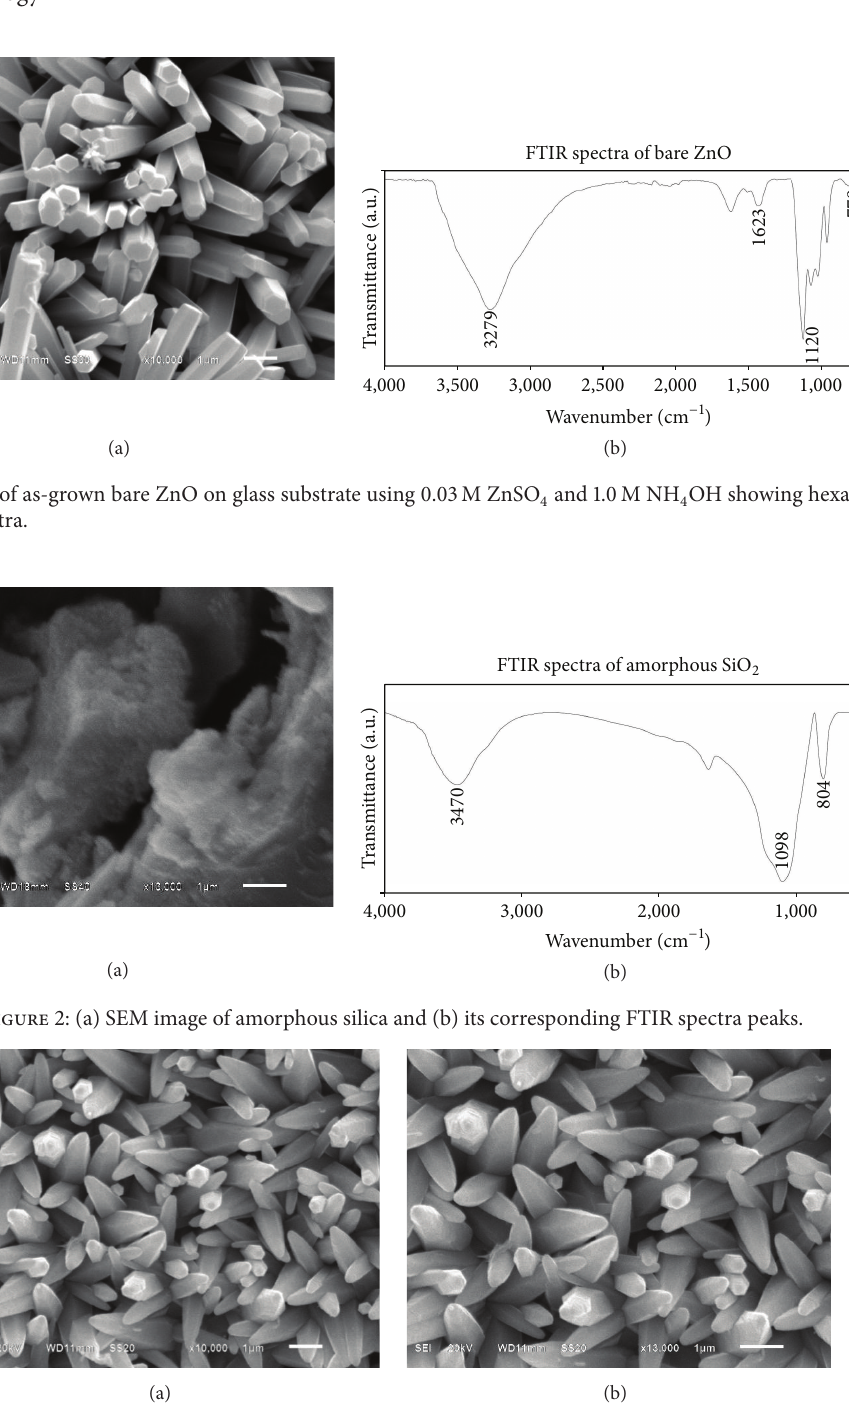
Figure 3: Micrographs of as-grown ZnO-SiO 2 on glass substrate using 1.0 M NH 4 OH. At (a) 10,000x magnification and (b) 13,000x